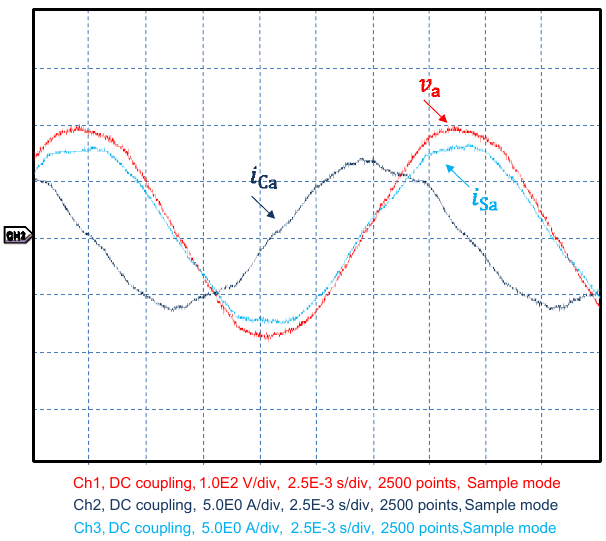
Figure 10. Experimental results—power factor control turned